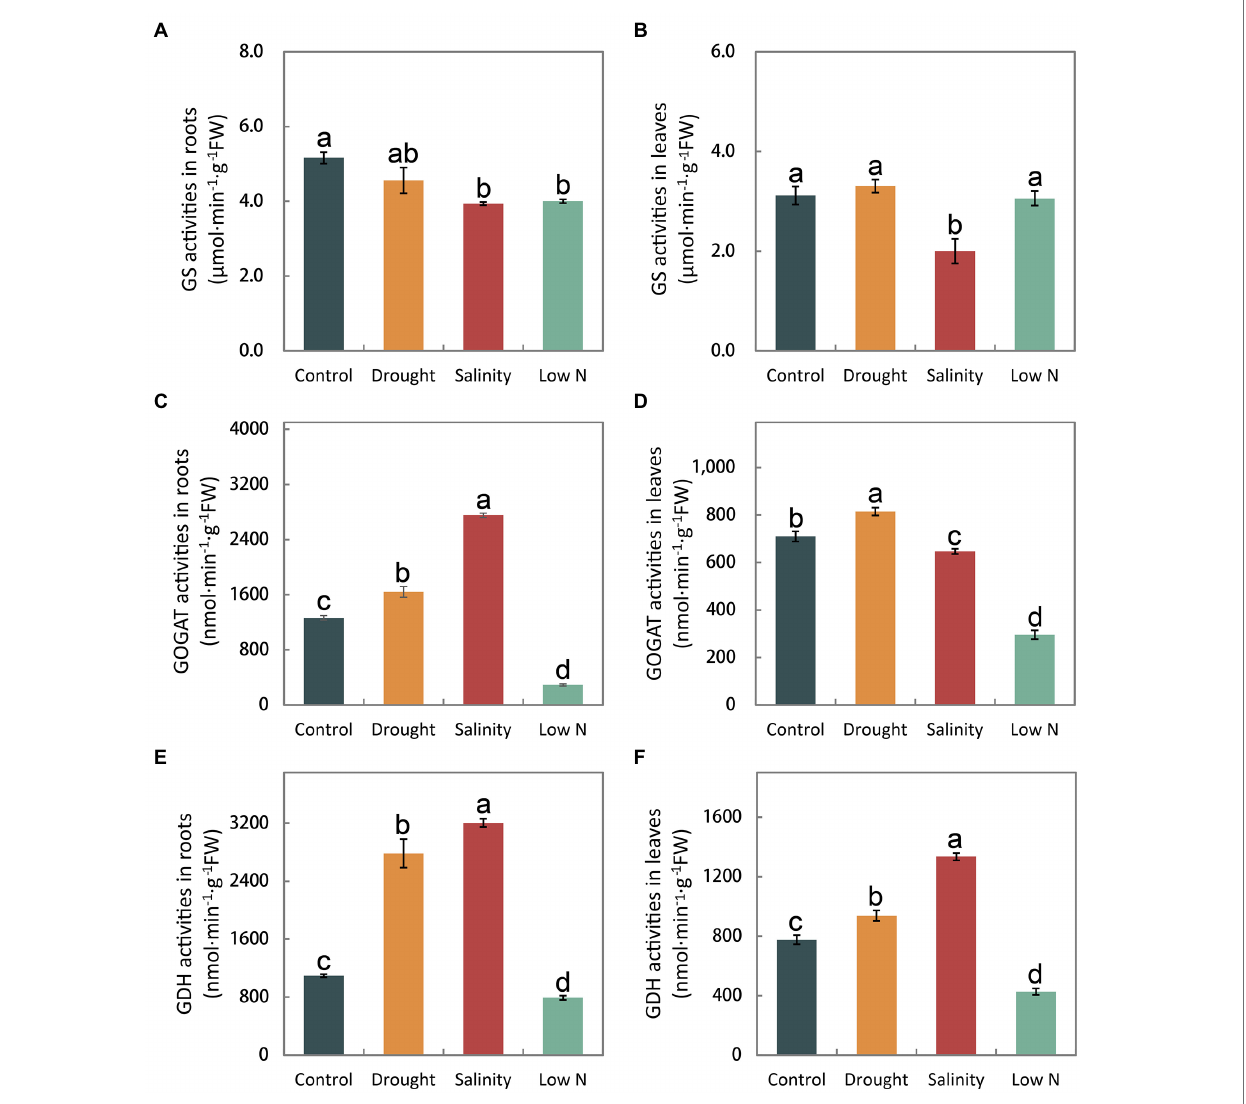
FIGURE 5 | Activities of glutamine synthetase, glutamate synthase, and glutamate dehydrogenase in roots (A,C,E) and leaves (B,D,F) of S. japonica as affected by drought, salinity, and low N treatment. Data indicate means ± SE of three replicates (12 plants). Bars labeled with different letters indicate significant differences between treatments ( p <